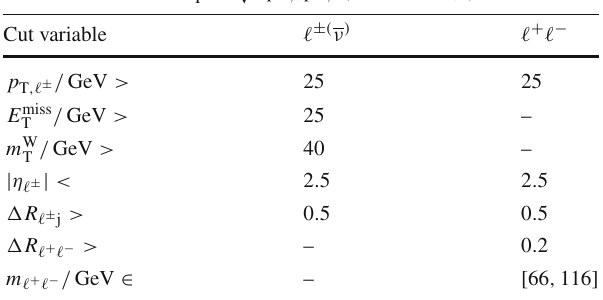
(cid:12) = 2 p T ,(cid:6) p T ,ν ( 1 − cos (cid:5)(cid:12) (cid:6)ν ) T